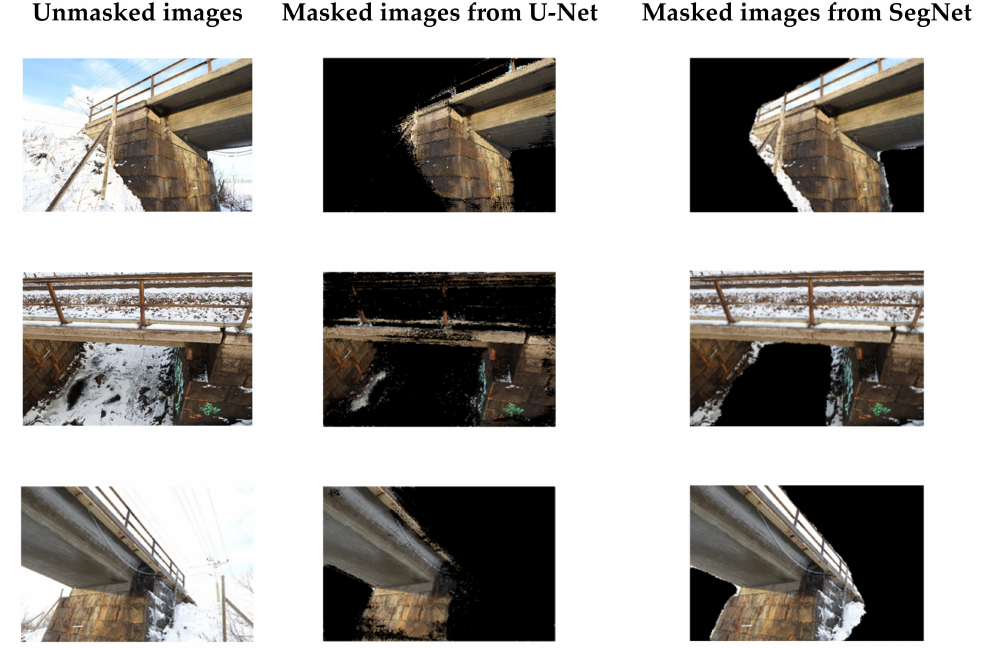
Figure 10. Detected bridge component by the studied CNNs.